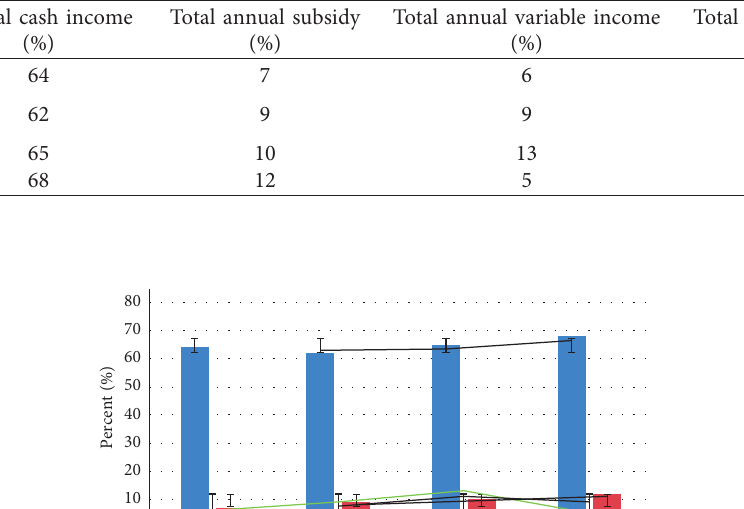
Table 13: Salary structure of human capital in high-tech enterprises.